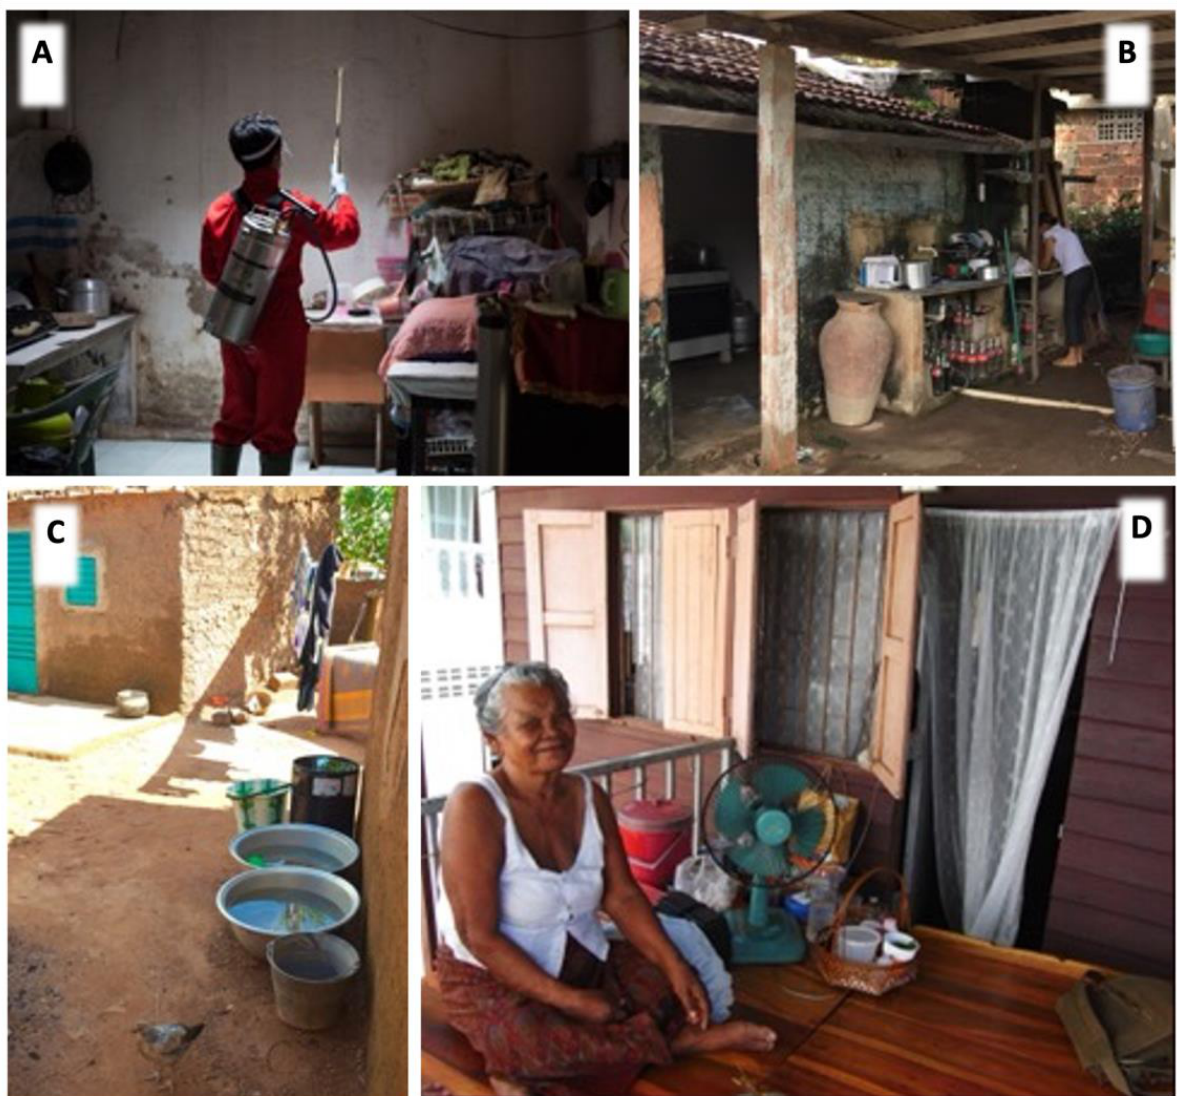
Figure 1. Vector preferences for host-seeking and resting behaviour influence vector control inter- ventions as does the community’s response to them. ( A ) Standard IRS involves the application of aqueous insecticide residues on indoor walls and ceiling and is most effective for vector control where endophily is the predominant behaviour; in a busy room such as this, where are the preferential resting sites? What could guide us in efforts to identify the spots preferred by Ae. aegypti , e.g., surface colour or texture, light intensity, flight paths, degree of cover, etc. to reliably identify them as target sites? ( B ) Where is, or what would be defined as indoor or outdoor in this dwelling in Recife, Brazil? ( C ) Ouagadougou Burkina Faso. Here, in a relatively arid region, the Ae. aegypti population is highly exophilic, but with a disproportionately high number of bloodfed females caught inside houses (see Badolo et al. 2022). This is in contrast to ( D ) Chon Buri in Thailand, where despite the high humidity, most biting occurs while humans are indoors. However, it is very hot indoors and people prefer to spend leisure time outdoors, negating the impact of the insecticide-treated curtains (visible in the doorway and windows behind), which form a barrier to house entry but con- tribute little to vector control as a result. (Figure 1A © Chris Barrett; Figure 1B – D © PJ McCall).